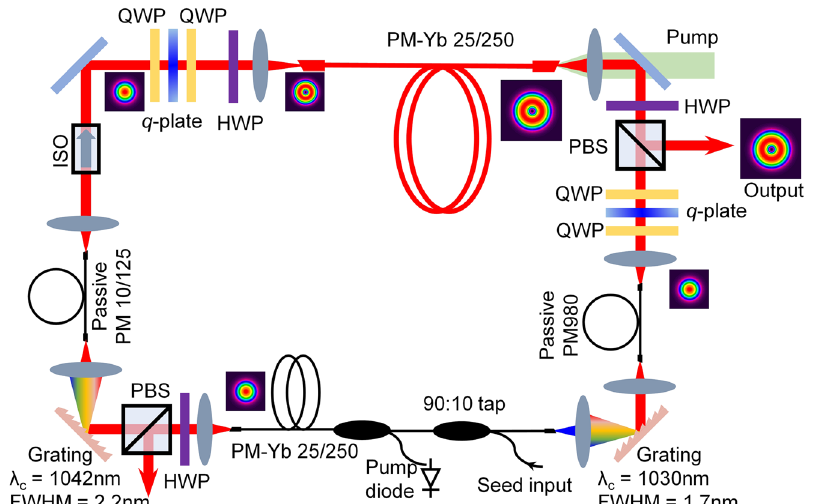
Figure 2: Schematic of the experimental setup. HWP: half-wave plate; ISO: isolator; PBS: polarization beam